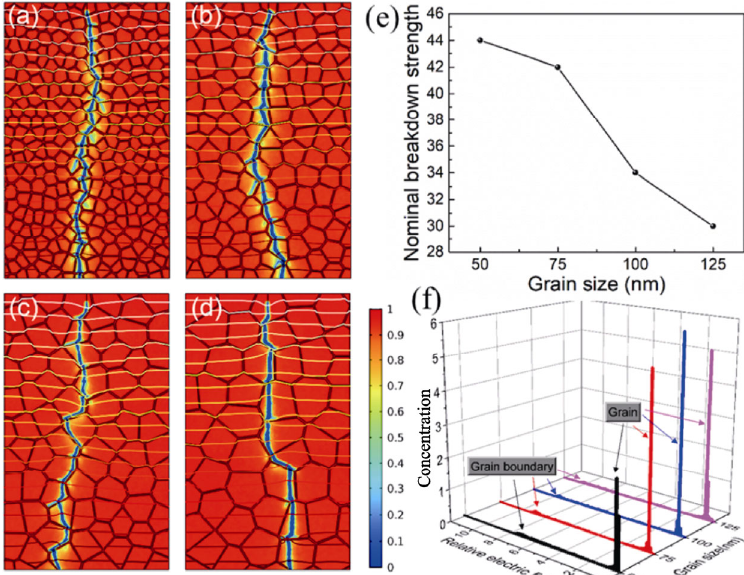
Fig. 17 Breakdown path featured for different grain sizes: (a) 50 nm, (b) 75 nm, (c) 100 nm, and (d) 125 nm. The contour lines are the equipotential lines of the then–current electric field. (e) Relation of the nominal breakdown strength against grain size. (f) Relative local electric field distribution of these ferroelectric ceramics at various grain sizes under a given applied electric field of 30 MV·m –1 . Reproduced with permission from Ref. [106], © The American Ceramic Society